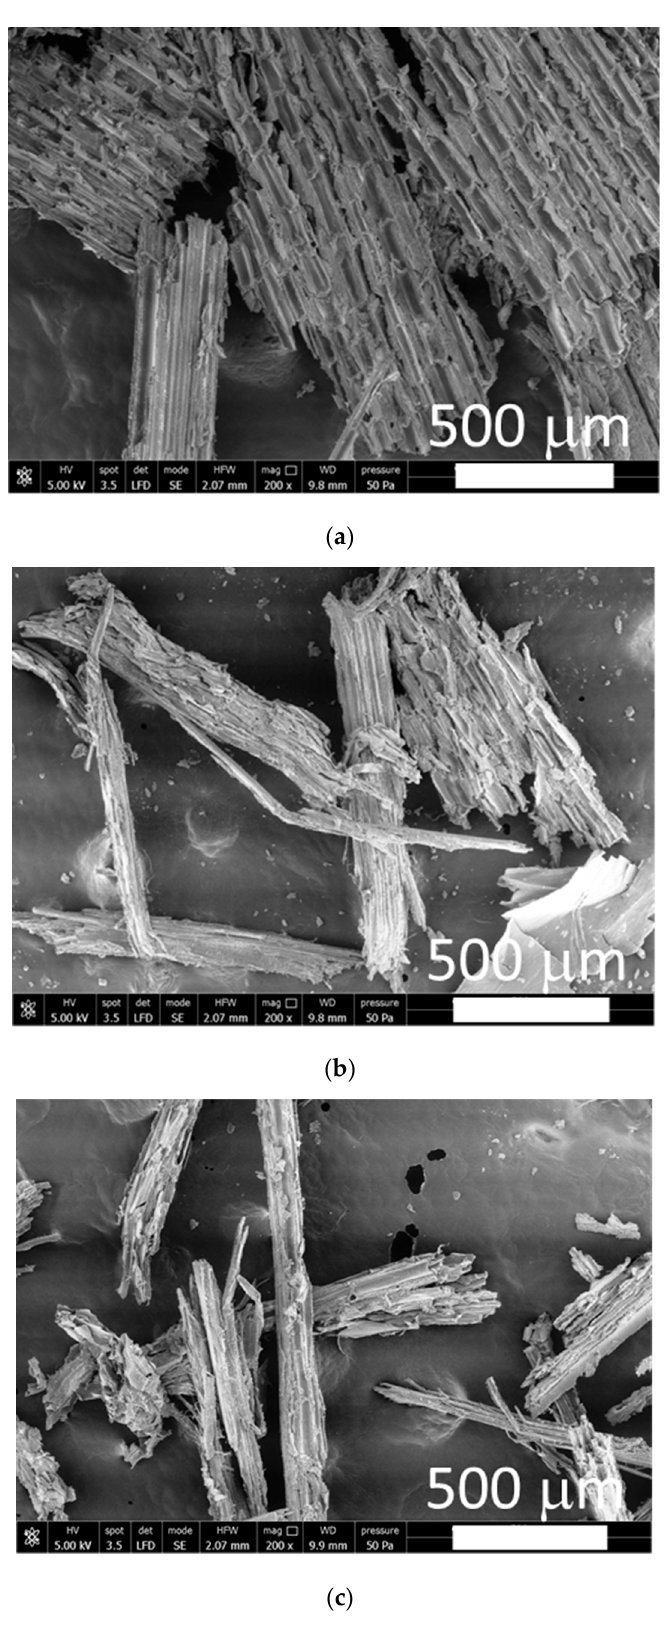
Figure 2. SEM images of ( a ) large-, ( b ) medium-, and ( c ) small-shaped Arundo donax fibers.